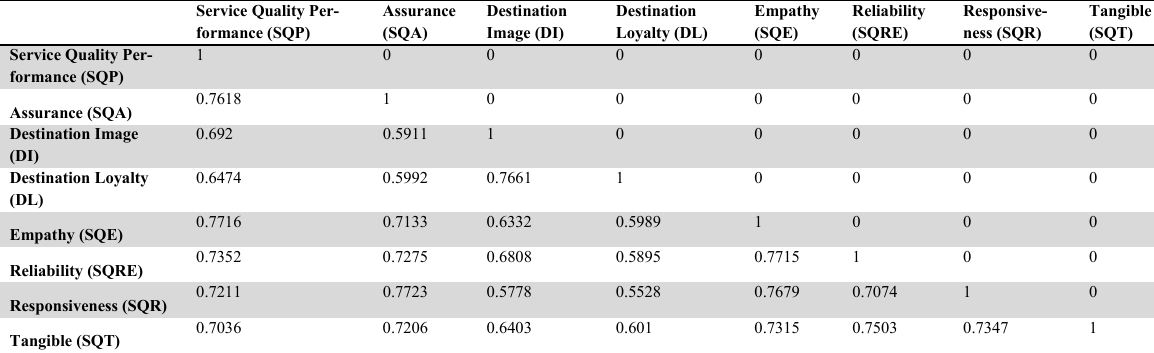
Summary of Correlations Between Coefficients Service Quality Per- Service Quality Per- formance